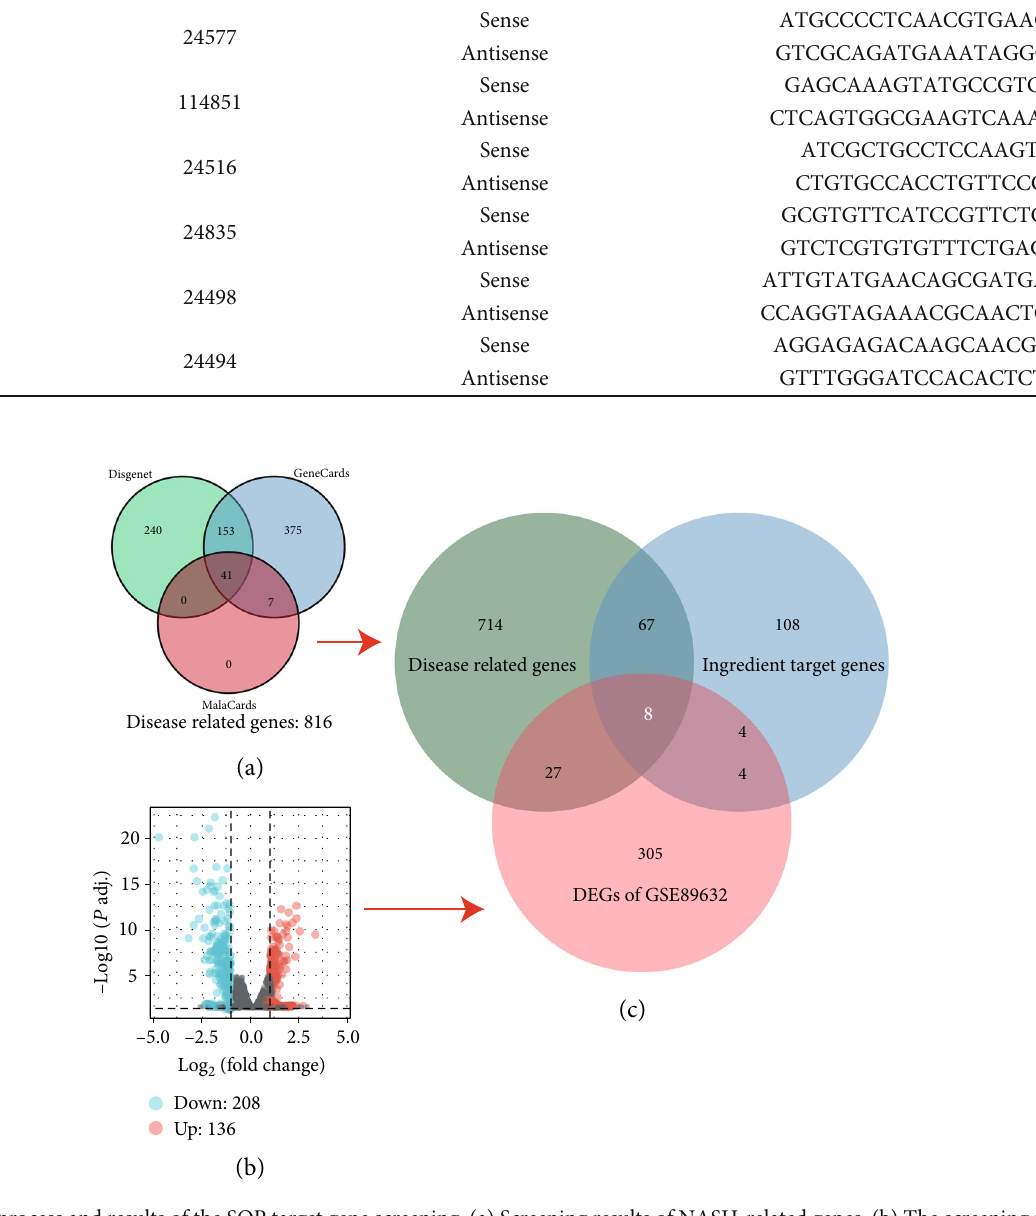
Figure 2: The process and results of the SQP target gene screening. (a) Screening results of NASH-related genes. (b) The screening results of DEGs. (c) The fi nal screening results of the SQP target